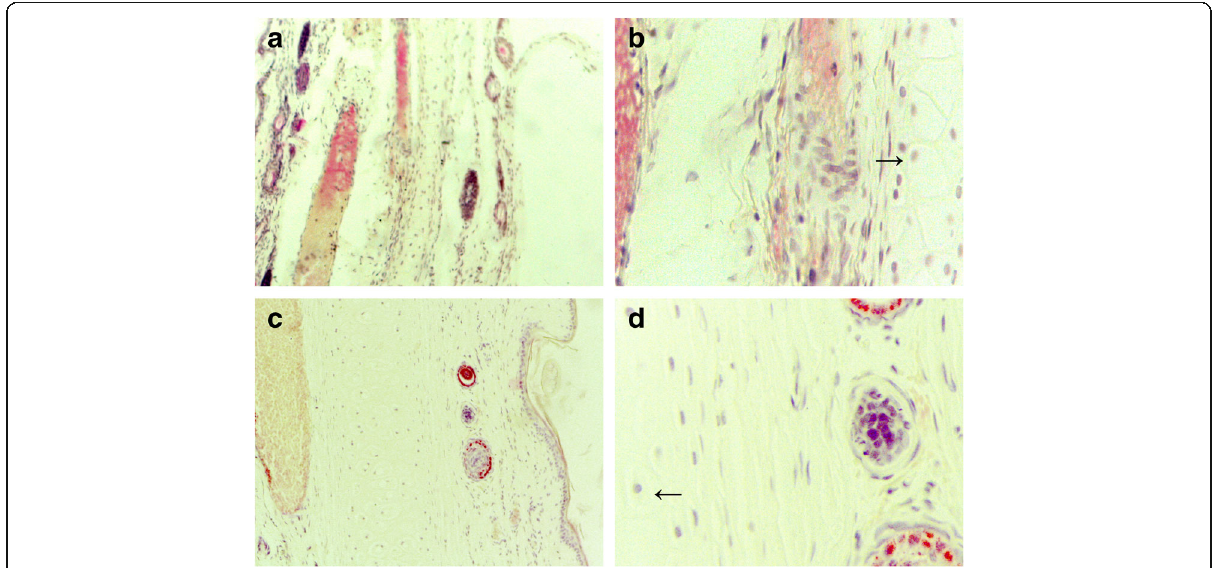
Fig. 7 Photomicrographs of the ear vein after infusion of 24 h stained by H&E. a , b Group of infusion with normal saline. c , d Group of infusion with PEG-PCCL. The needles represent the auricular cartilage. (Left image × 10, right image ×